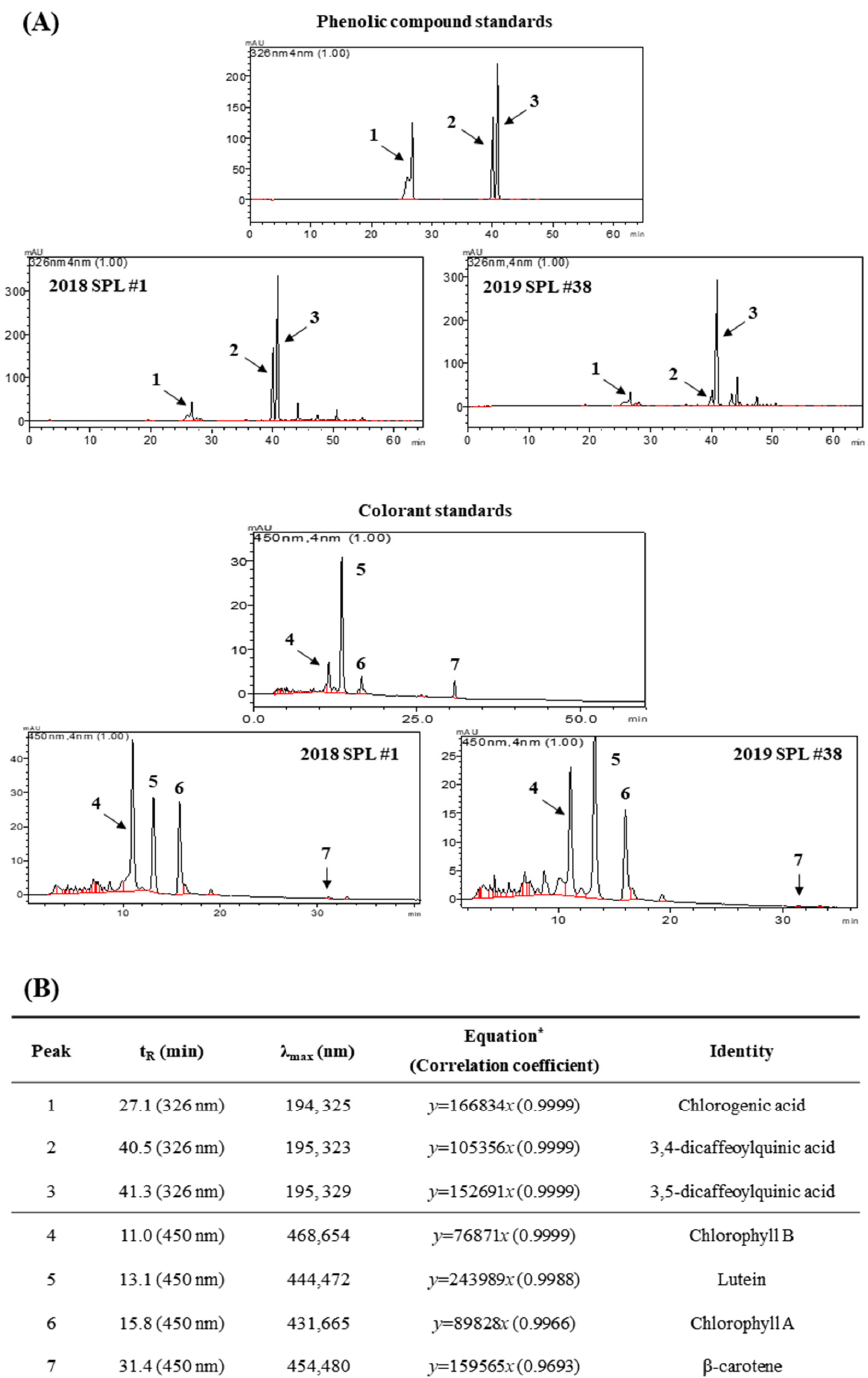
Figure 1. Chromatography of phenolic compounds and pigments in standards and SPL. High performance liquid chromatography (HPLC) was used for analysis of phenolic compounds and pigments in SPL at 326 nm and 450 nm of wavelength. ( A ) Chromatography peaks of phenolic compounds (peak #1, 2 and 3) and pigments (peak #4, 5, 6 and 7) in standards and sweetpotato leaves. ( B ) Peak assignments, retention times and wavelengths of maximum absorption for standard phenolic compounds. * y expresses the detection response (peak area), and x is the concentration for phenolic compounds. 1: Chlorogenic acid, 2: 3,4-dicaffeoylquinic acid, 3: 3–5-dicaffeoylquinic acid, 4: Chlorophyll B, 5: Lutein, 6: Chlorophyll A and 7: β